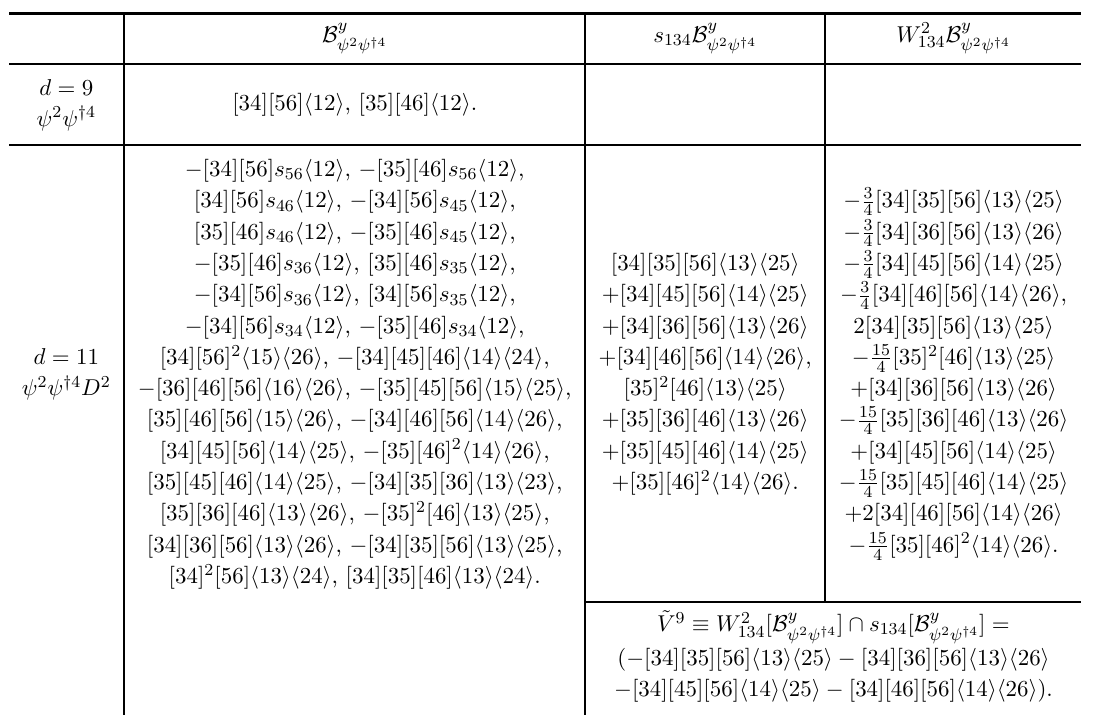
Table 31 . Y-basis and j-basis of ψ 2